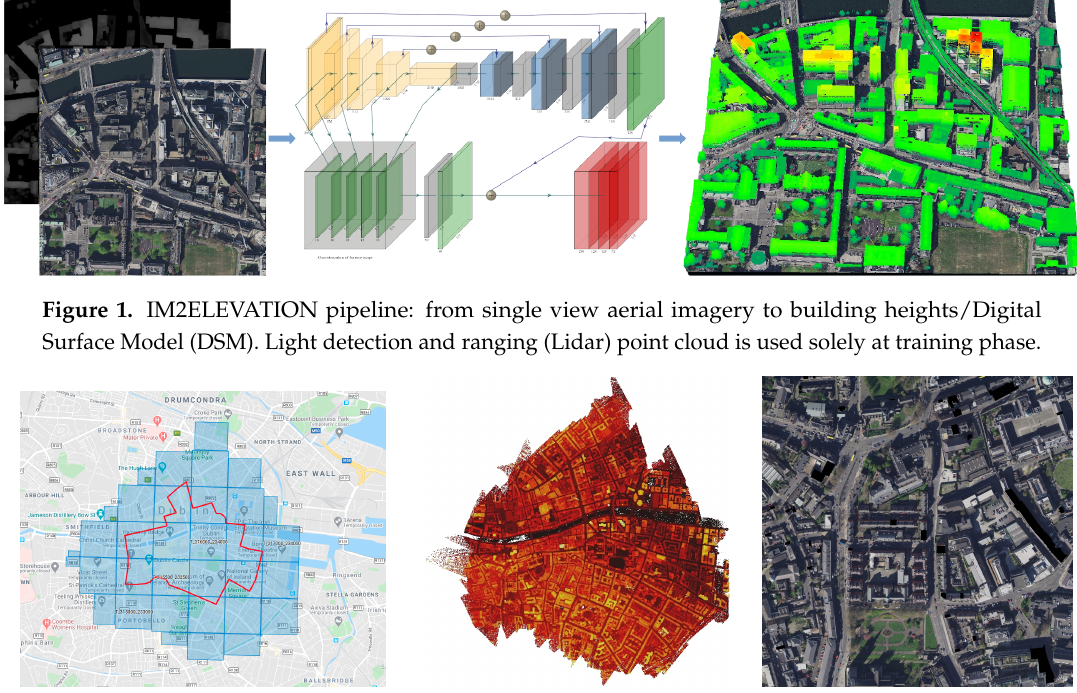
aerial tiles (blue) and Lidar cover (red) Figure 2. Study case of building heights in Dublin